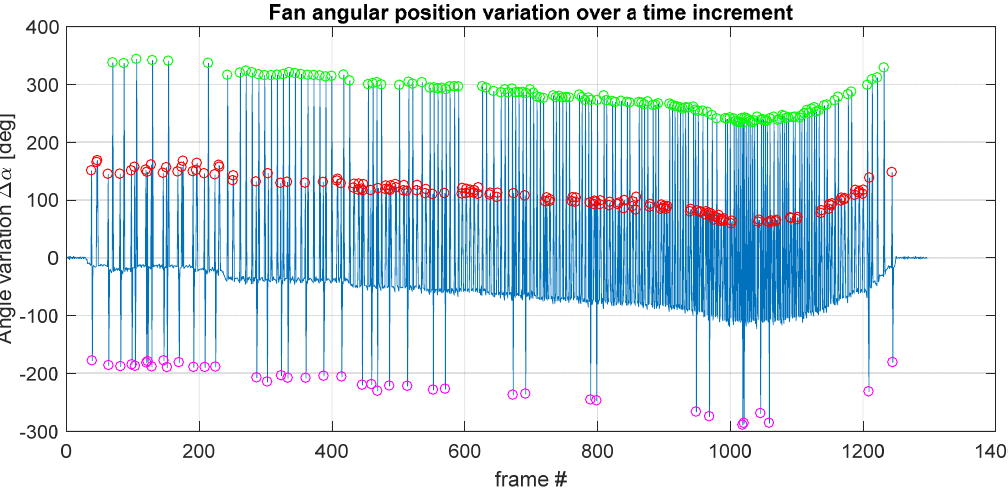
Figure 10. Fan angular position variation (angular increments ∆ α ) over time (frame index). In green are the points for the “unwrap”, in red and magenta are the errors to be compensated (8.8 logo missed).